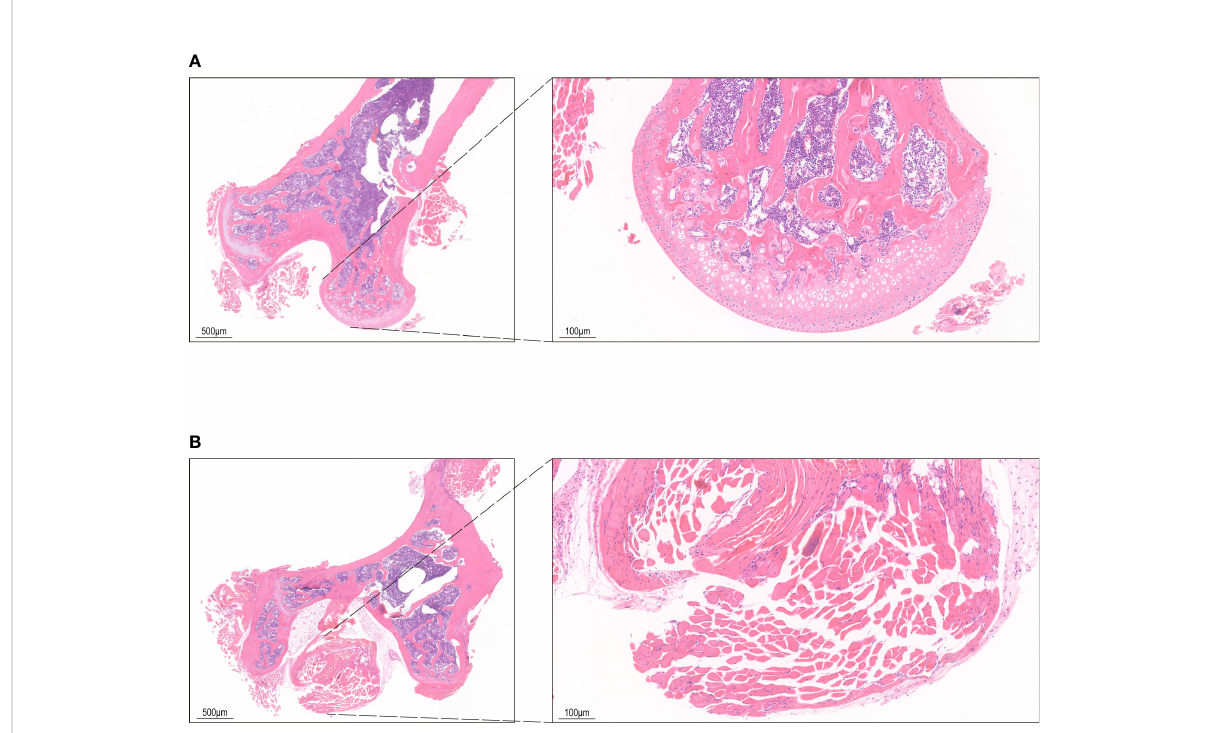
FIGURE 1 HE staining of bone tissue. (A) The control group shows bone cells in the bone lacunae, uniform nuclear staining and regular trabecular morphology. (B) HE staining in INFH group shows bone lacuna formation, sparse bone trabeculae, and disordered